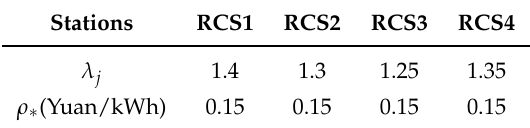
Table 4. Profit coefficient and additional charging charge.